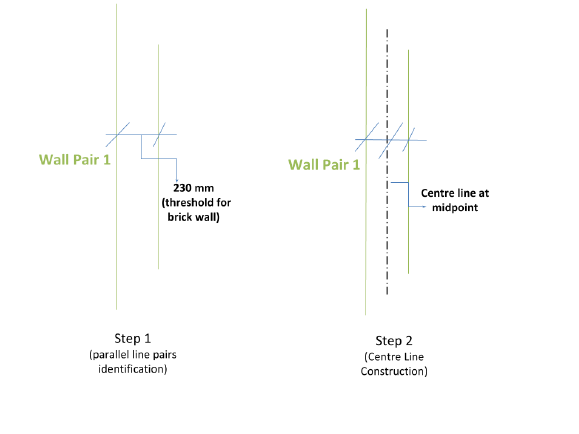
Figure 3. Identification of wall pairs and centreline generation